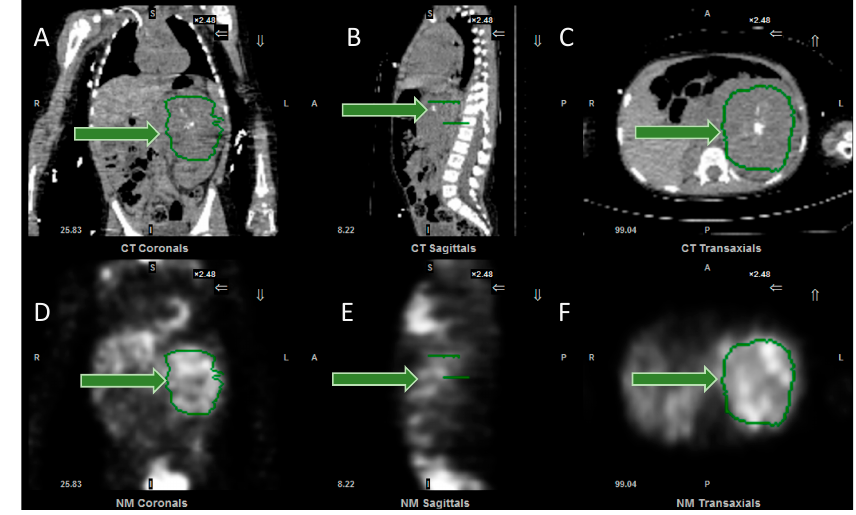
Figure 5. Images from the software to measure SPECT SUV (standardised uptake values). ( A ) Coronal, ( B ) sagittal and ( C ) axial CT images, together with ( D ) coronal, ( E ) sagittal and ( F ) axial SPECT images, demonstrating the tumour, outlined in green (arrowed). Following input of data, including administered activity and organ delineation, the system will calculate the minimum, maximum and mean (standard deviation) of the SUV, expressed as g/mL. Same patient as in Figure 1.